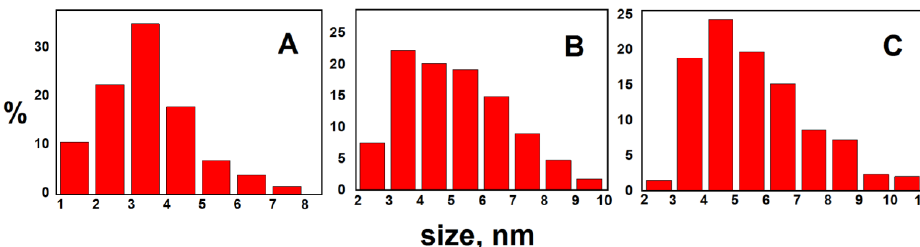
Figure 5. The size distributions of AuNPs obtained in VT – Au(III) solutions irradiated to a dose of 14 kGy (( A ) – 80/1, ( B ) – 40/1) and 23 kGy (( C ) – 40/1).